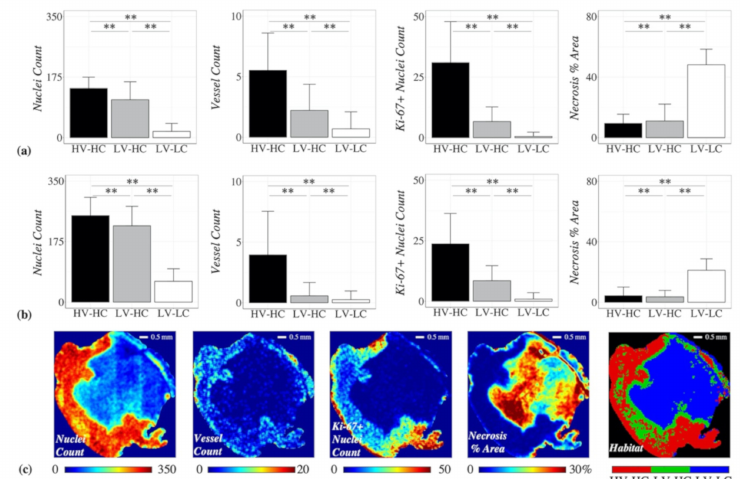
Figure 4. The mean stain density values for each of the histological habitats are shown for the ( a ) BT-474 and ( b ) MDA-MB-231 cohorts. The mean vessel count and nuclei count values were used to identify the physiological habitat each cluster represented in terms of high or low “vascularity” or “cellularity”, respectively. The three identified habitats were as follows: high-vascularity high-cellularity (HV-HC), low-vascularity high-cellularity (LV-HC), low-vascularity low-cellularity (LV-LC). All three habitats were found in both the BT-474 and MDA-MB-231 cohorts. Error bars show standard deviation and ** indicates a p < 0.01. Panel ( c ) shows representative stain density maps and a corresponding habitat map for an example MDA-MB-231 tumor from the low-dose ABP treatment group, where the HV-HC habitat is shown in red, LV-HC in green, and LV-LC in